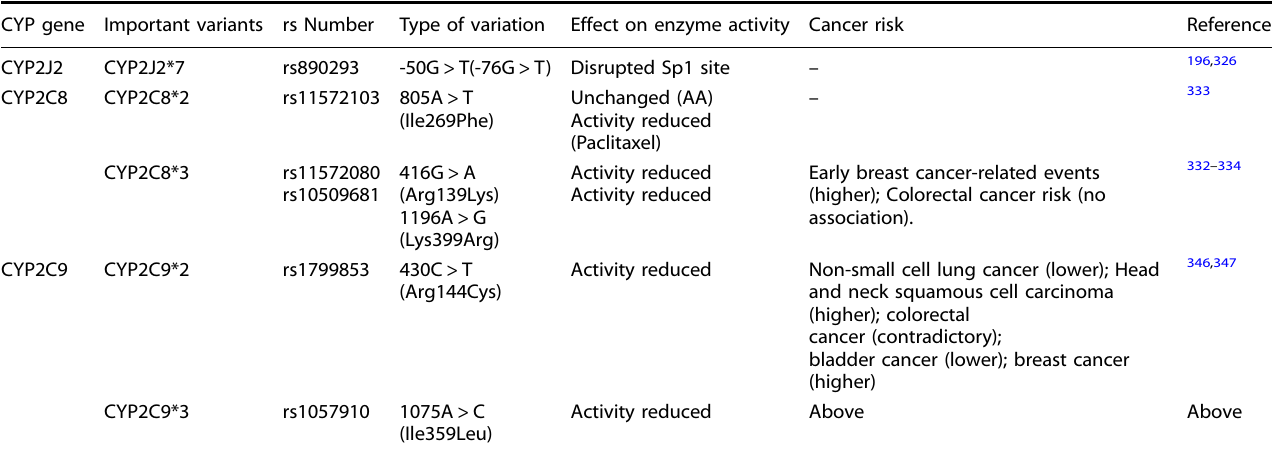
Table 2. Gene polymorphism of several human CYP epoxygenases and tumor